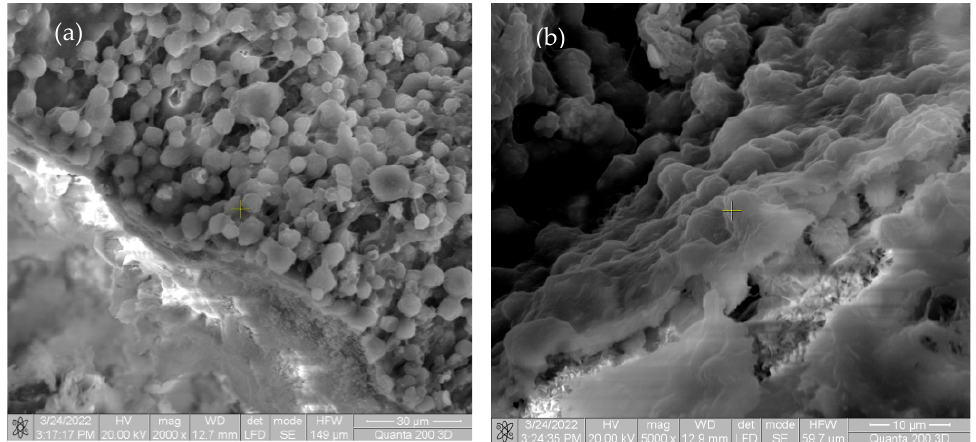
Figure 6. SEM images of rats after two weeks ( a ) at magnification of 2000×; ( b ) at magnification of 5000×.